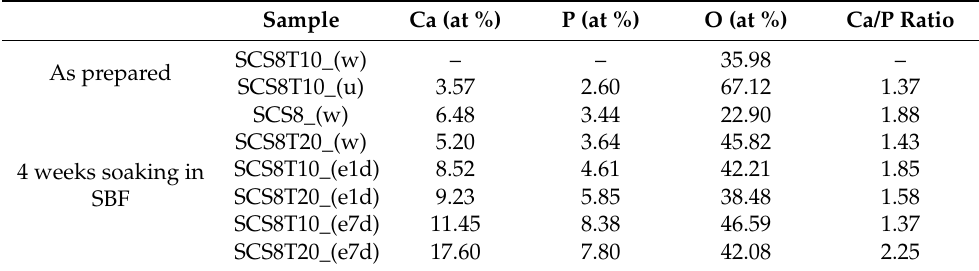
Table 4. Surface composition by EDS analysis of the various xerogels used in this